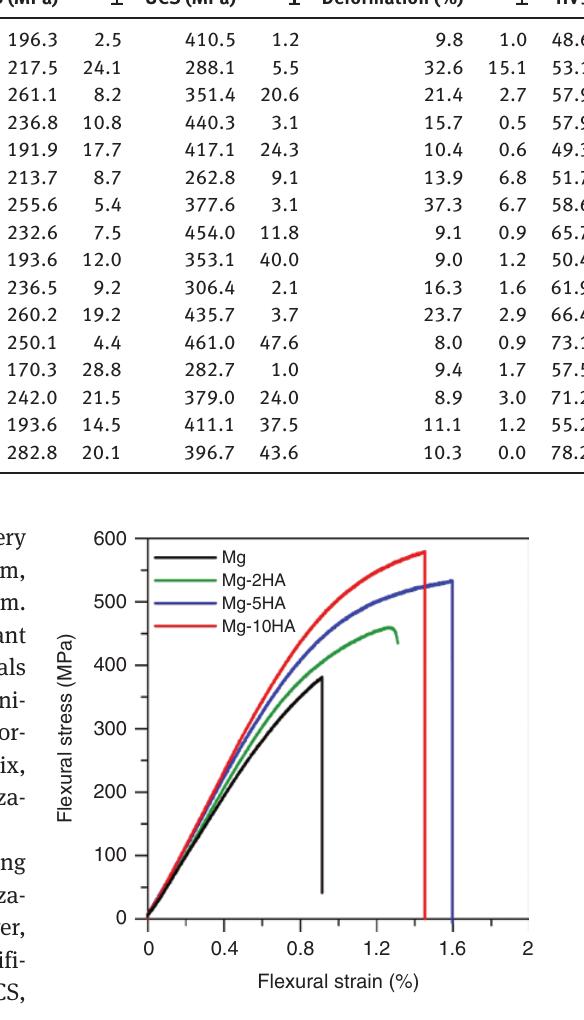
Figure 10: The effect of HA volume fraction on flexural properties of Mg-HA prepared by mixing of powders in planetary mill and subse- quent extrusion at 400 °